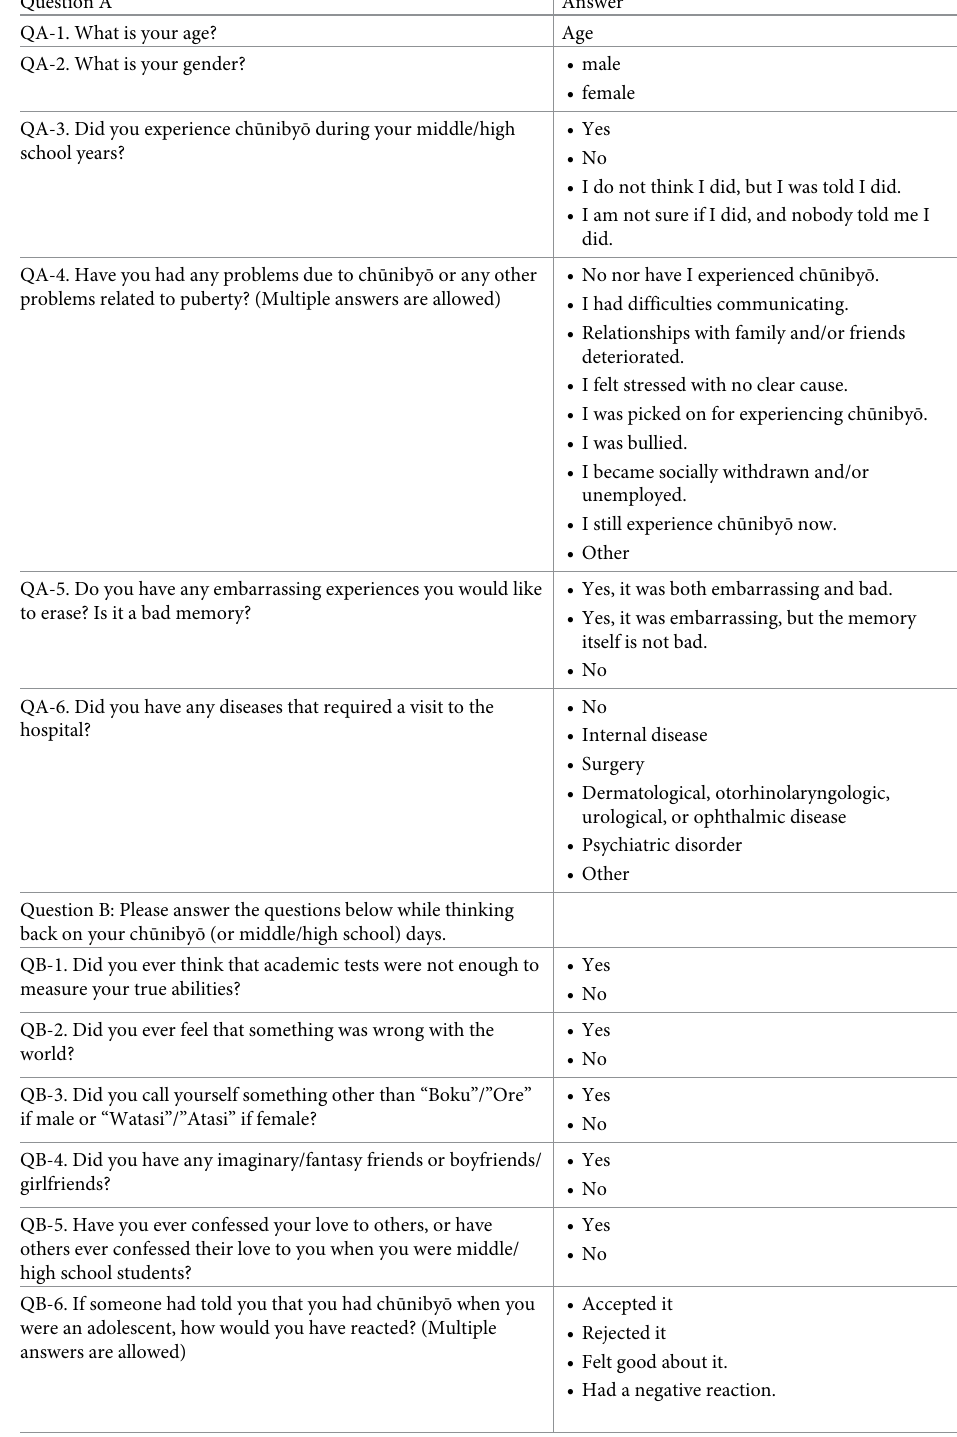
Table 1. The English translation of the questionnaire used in the